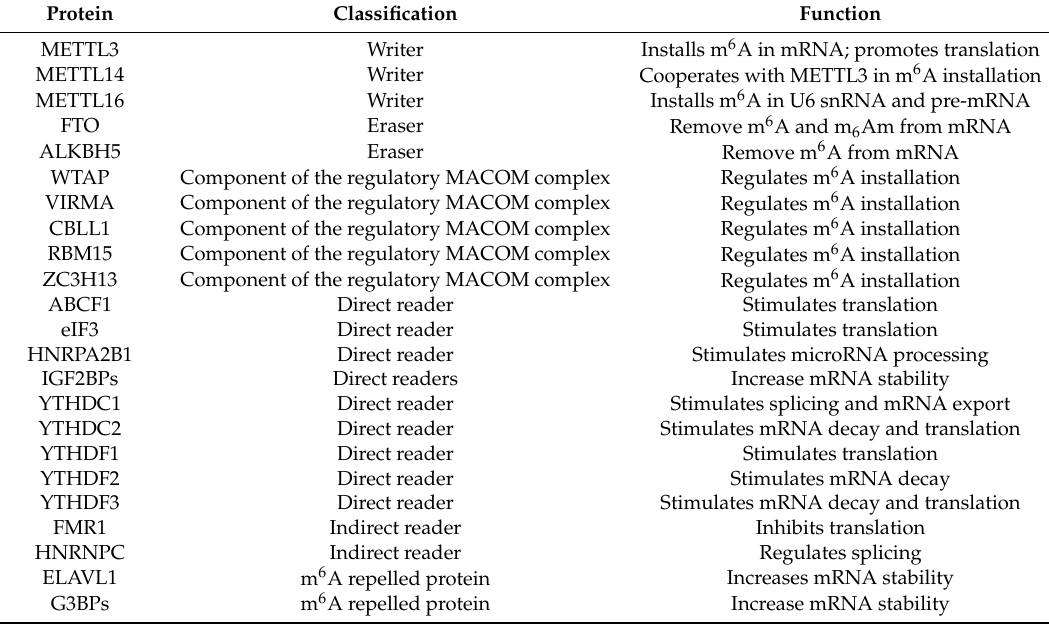
Table 1. Mammalian m 6 A (N6-methyladenosine)